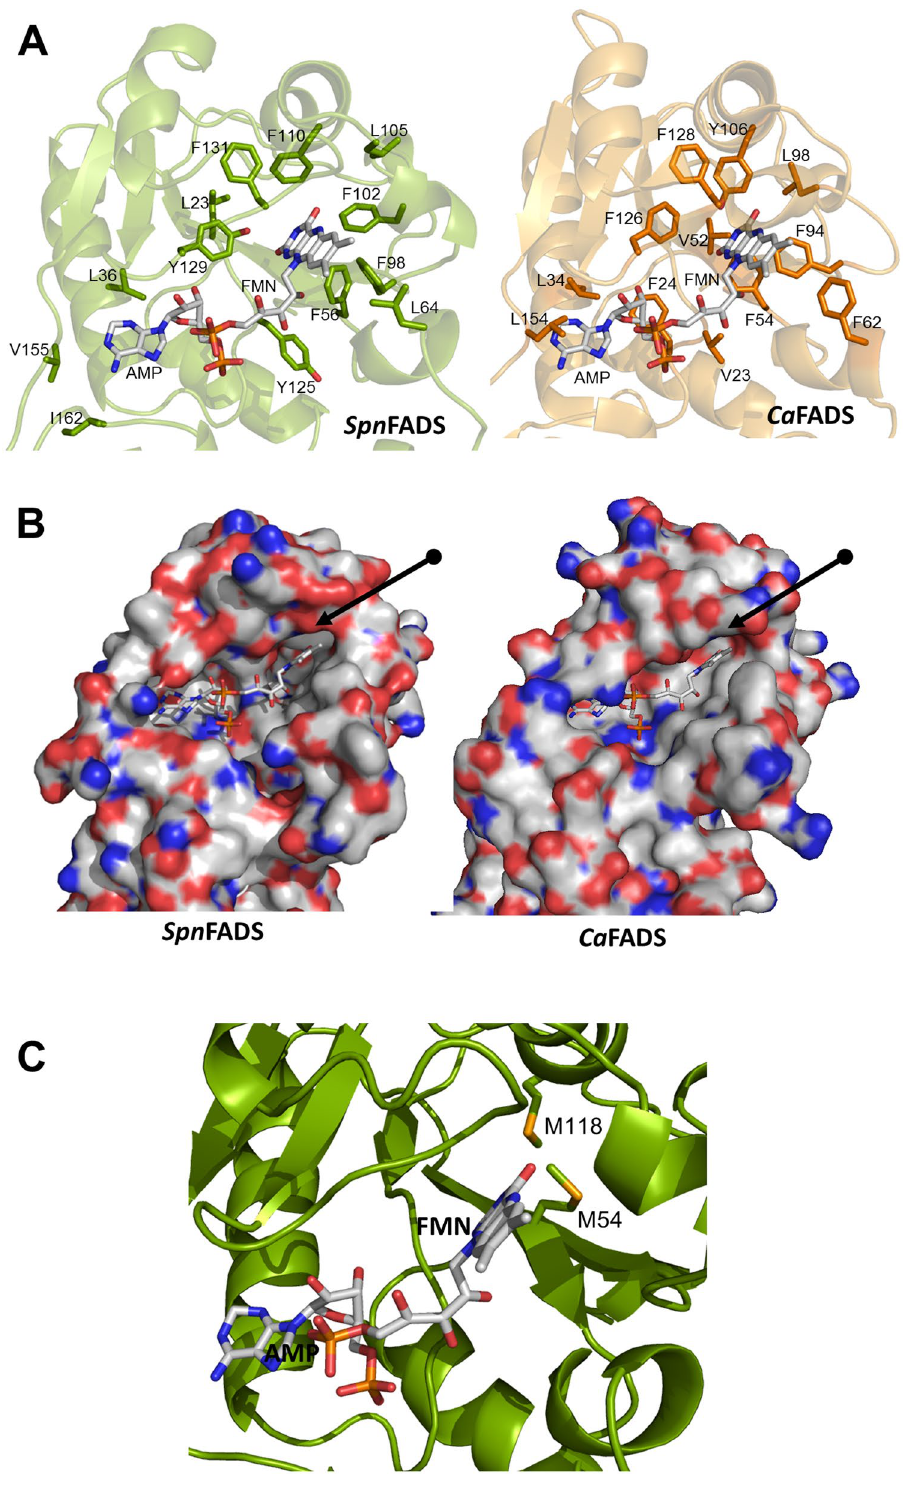
Figure 6. Comparative analysis of the Spn FADS and Ca FADS active sites in the FMNAT module. ( A ) Site for ligands binding in Spn FADS (green) and Ca FADS (orange). Hydrophobic and aromatic side chains are shown in sticks. ( B ) Surface electrostatic potential for the isoalloxazine binding cavity in Spn FADS (left panel) and Ca FADS (right panel). Arrows point to differences in sign of surface electrostatic potential at the Spn FADS and Ca FADS isoalloxazine sites. ( C ) Relative disposition of M54 and M118 regarding the isoalloxazine moiety of the flavin substrate. In all panels, FMN and AMP have been modelled on the crystals structures of Spn FADS (PDB ID: 3OP1) and Ca FADS (PDB ID: 2X0K) and represented in CPK sticks with carbons in grey 10